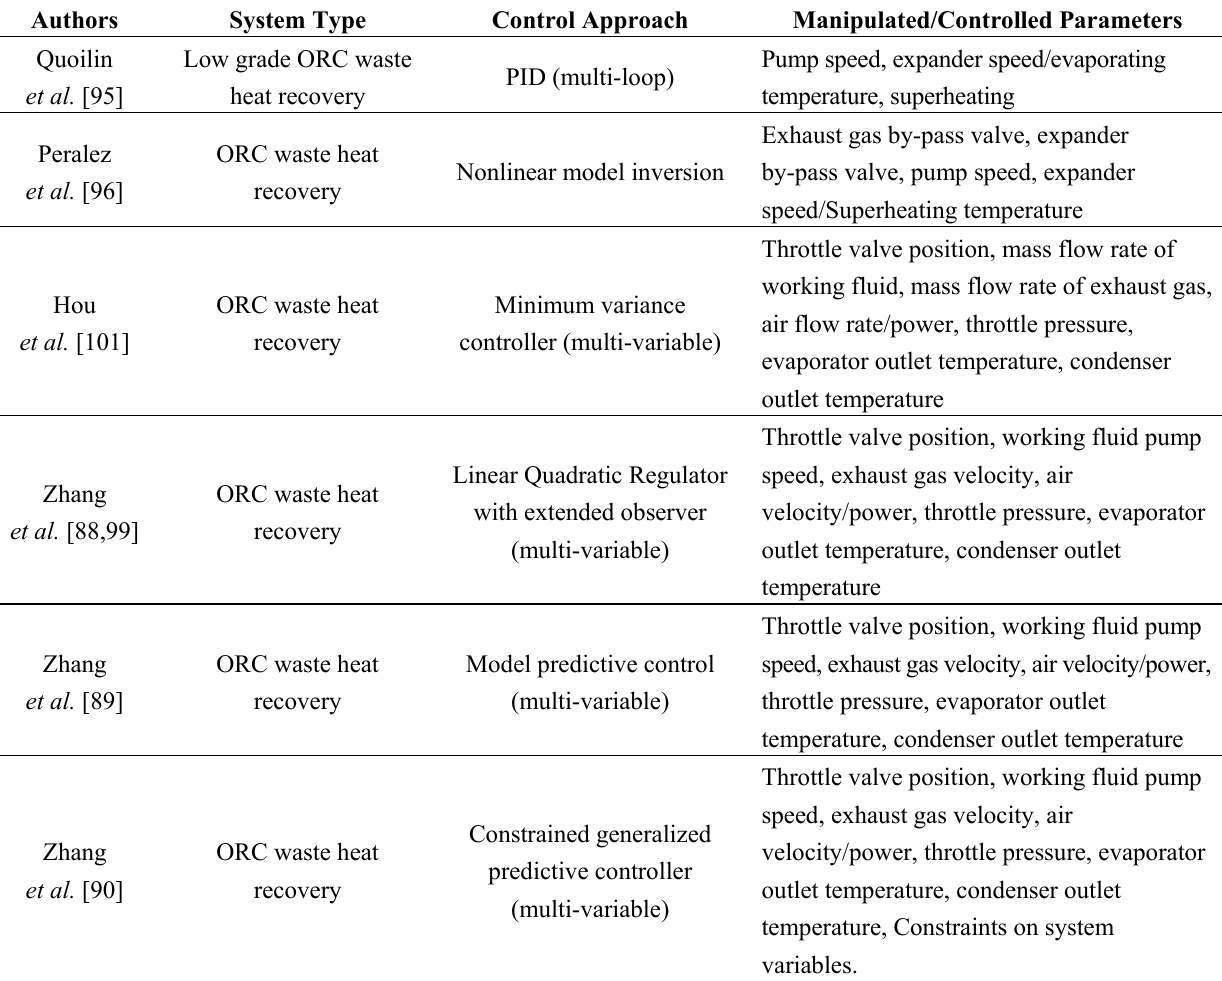
Table 9. Control